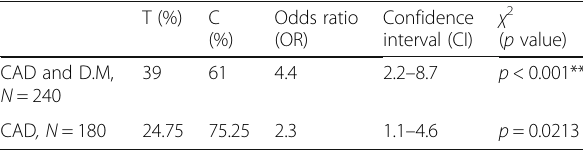
Table 3 Association between allele of the GLUL polymorphism rs10911021 and risk of CAD in T2DM patients χ 2 T (%) C Odds ratio Confidence ( p value) (%) (OR) interval (CI) CAD and D.M, 39 61 4.4 2.2 – 8.7 N = 240